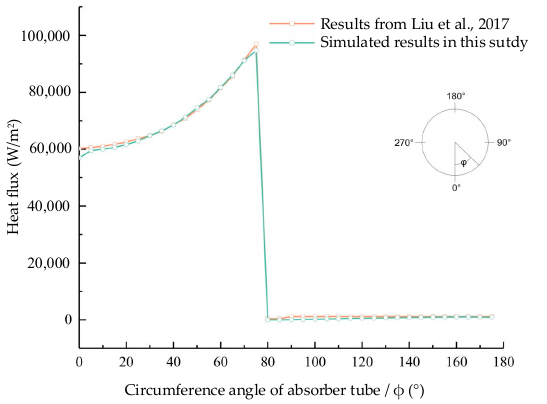
Figure 6. Comparison of PTC radiation distribution on the absorber outer surface between the simulated results in this study and Liu, et al., 2017 (Ref. [38]).